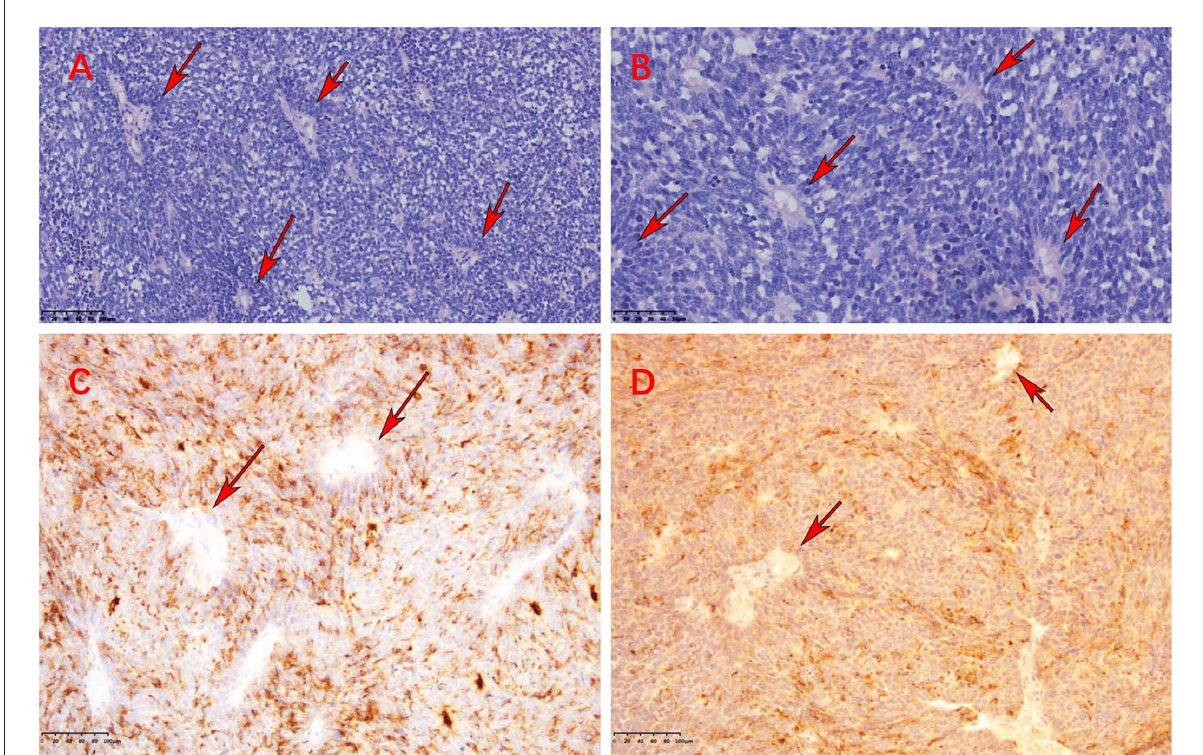
FIGURE2 (A,B) High magnification view showed multiple rosettes of ependymoblastoma consisting of a concentric arrangement of small blue round cells around the cavity with nuclear pleomorphism and mitotic activity (HE, × 200 and HE, × 400). (C,D) Immunohistochemical staining was positive for EMA and Syn, respectively ( × 100) (these red arrows indicate multiple